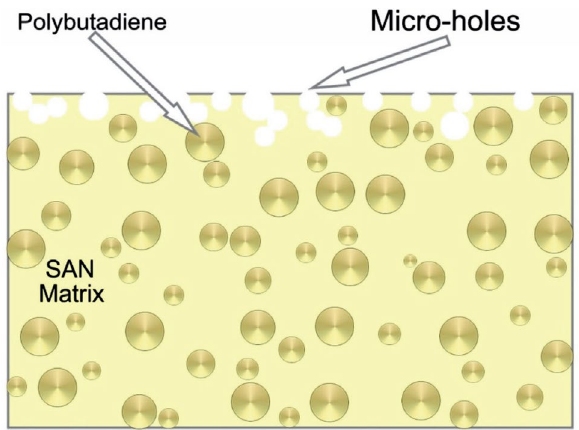
Figure 1. Schematic representation of the poly(butadiene) distribu- tion in the matrix of poly(styrene-acrylonitrile) (SAN) and mi- cro-voids formation due to selective etching with the sulfuric-chro- mic acid